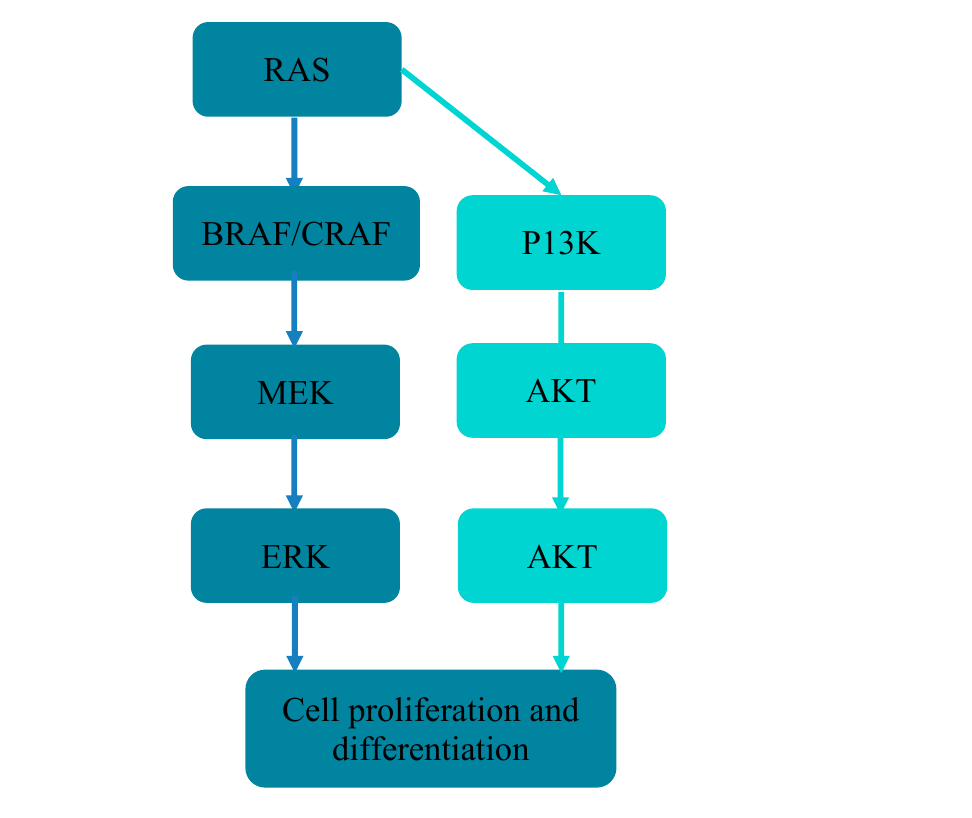
Figure 1. The molecular mechanism of BRAF and its activation of the MEK/ERK signaling and related down signaling pathways.